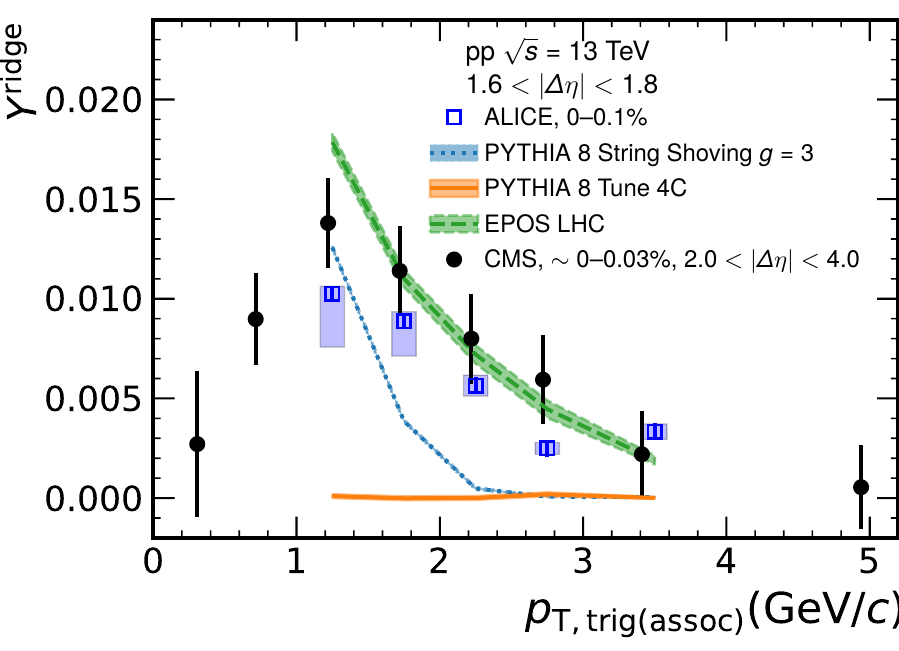
Figure 3 . Fully corrected near-side ridge yield as a function transverse momentum. The open blue boxes denote the measurement by ALICE. The statistical and systematic uncertainties are shown as vertical bars and boxes, respectively. The CMS measurement [19] is represented by filled circles and extends down to lower p T due to the larger ∆ η acceptance (see section 3). The three lines show model predictions from PYTHIA 8 Tune 4C (blue dotted line), PYTHIA 8 String Shoving (orange line), and EPOS LHC (green dashed